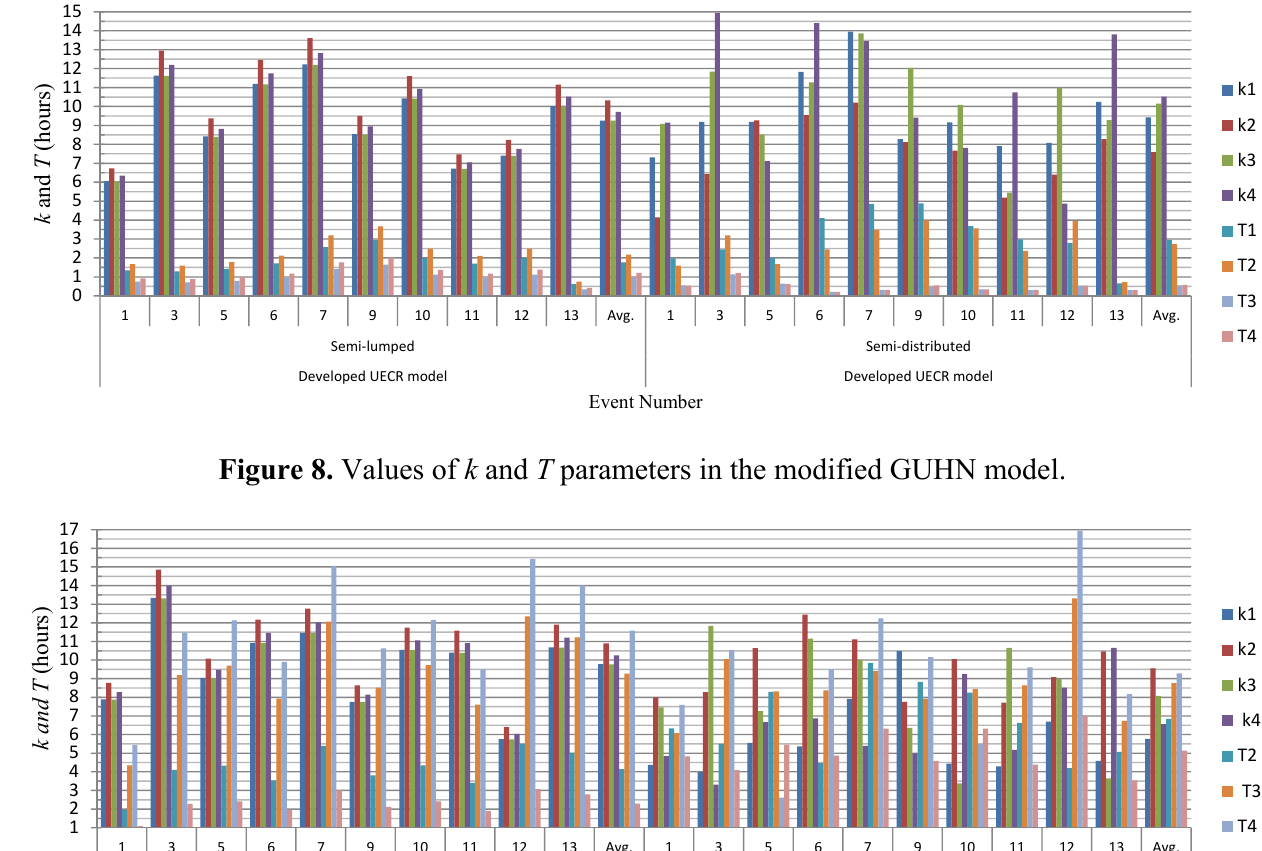
Figure 7. Values of k and T parameters in the UECR model.